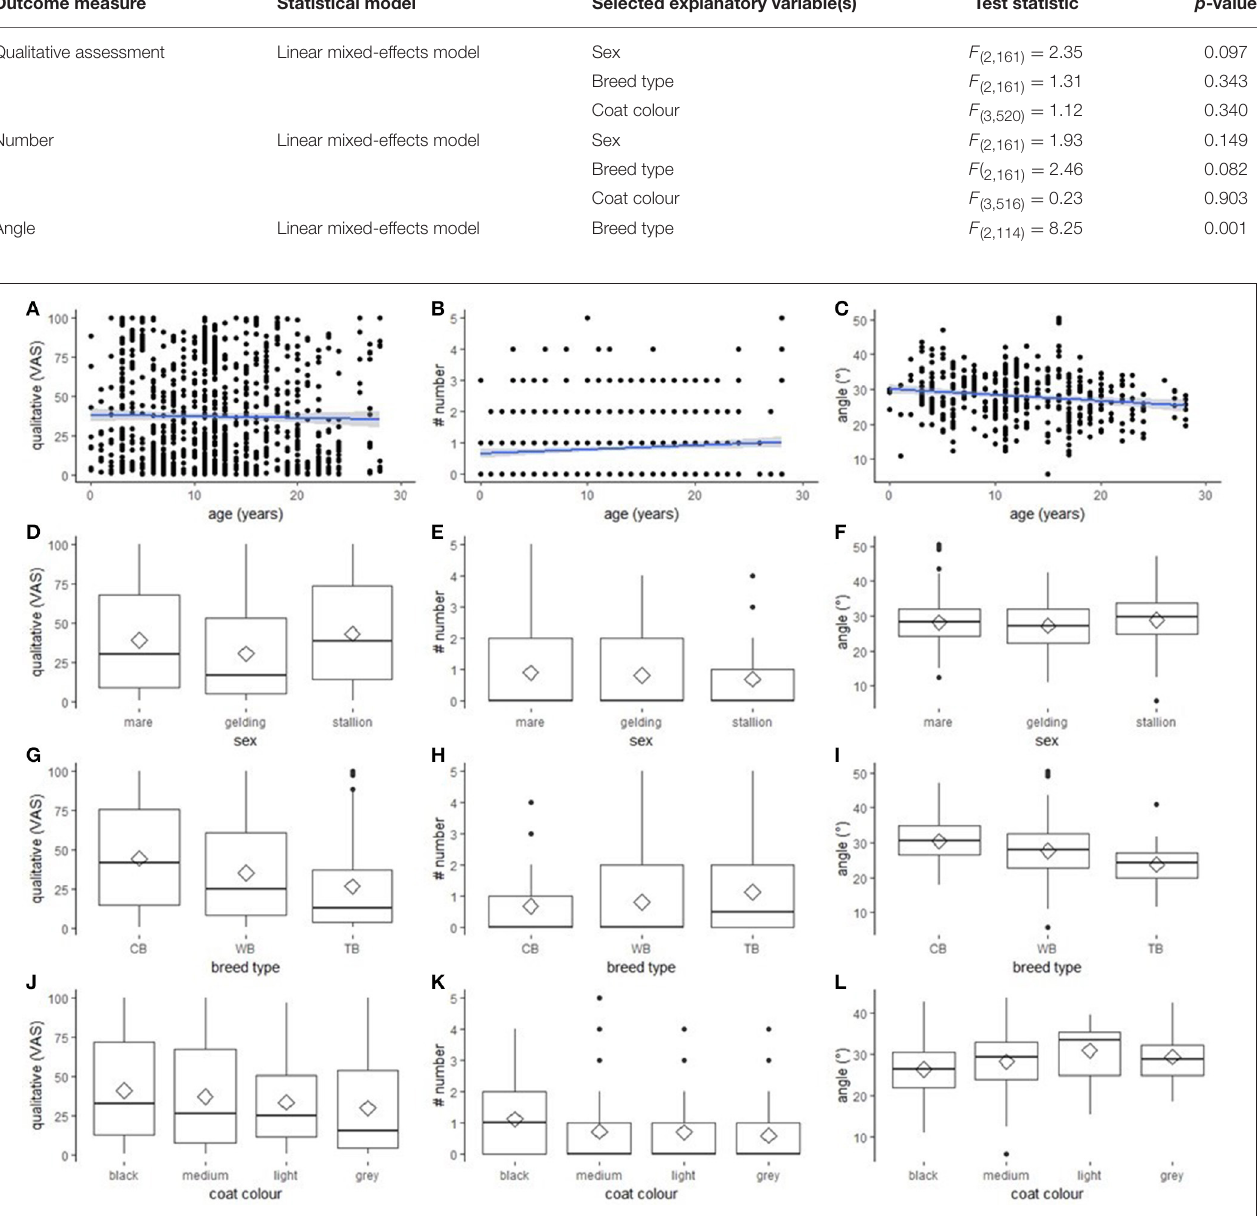
FIGURE 2 | Effect of “age”, “sex”, “breed type”, and “coat colour” on the three outcome measures. The effect of “age”, “sex”, “breed type”, and “coat colour” on the outcome measures “qualitative assessment”, “number”, and “angle.” (A–C) scatter plots with regression line (method = lm, blue line) with 0.95 confidence intervals (grey). (D–L) boxplots with median (black line), mean (diamond), interquartile range (box), 1.5 × interquartile range (whiskers). (A,D,G,J) “qualitative assessment” assessed on Visual Analogue Scale. (B,E,H,K) “number” of wrinkles. (C,F,I,L) “angle” measured in degrees. (G–I) “breed type”: coldblood (CB), warmblood (WB), thoroughbred (TB). (J-L) “coat colour”: black or dark bay (dark), medium bay (medium), light bay and palomino (light), grey and white